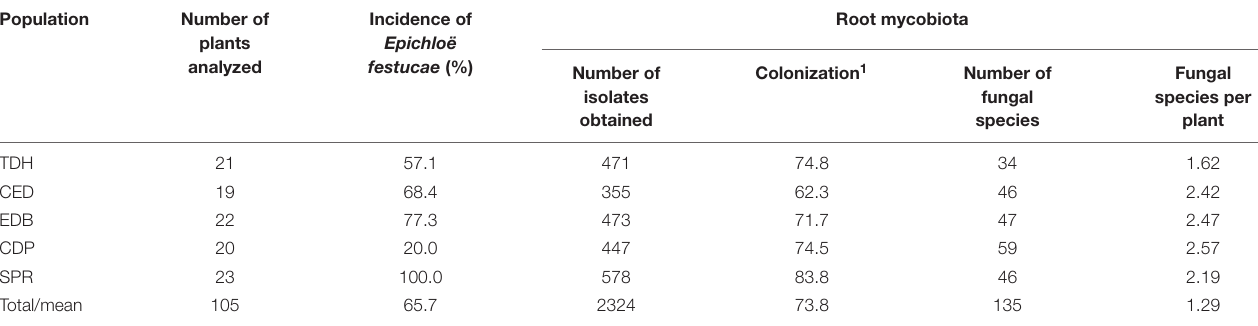
TABLE 1 | Incidence of Epichloë and fungal species richness in roots of Festuca rubra subsp. pruinosa at five populations from marine cliffs in Northern Spain. Population Number of